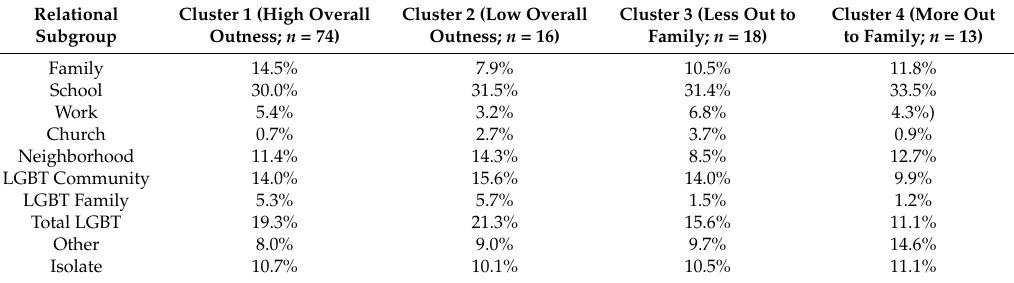
Table 1. The Facebook Network Composition by Outness Cluster Type.